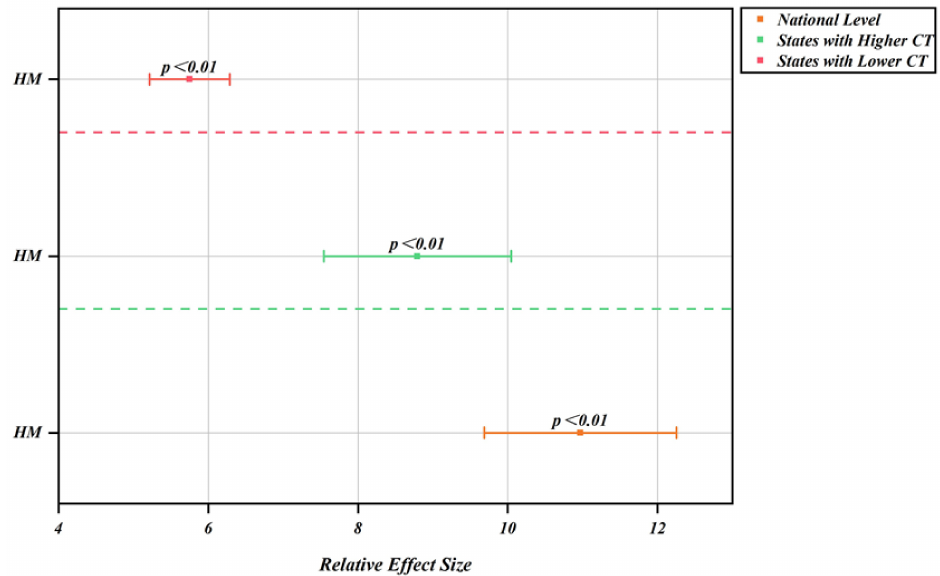
Figure 3. Displays the empirical results of our instrumental variable analysis, i.e., Model I with human mobility ( HM) replaced by an estimator that is based on the daily Bitcoin price, using the dataset of the national level as well as the classified states, see Table